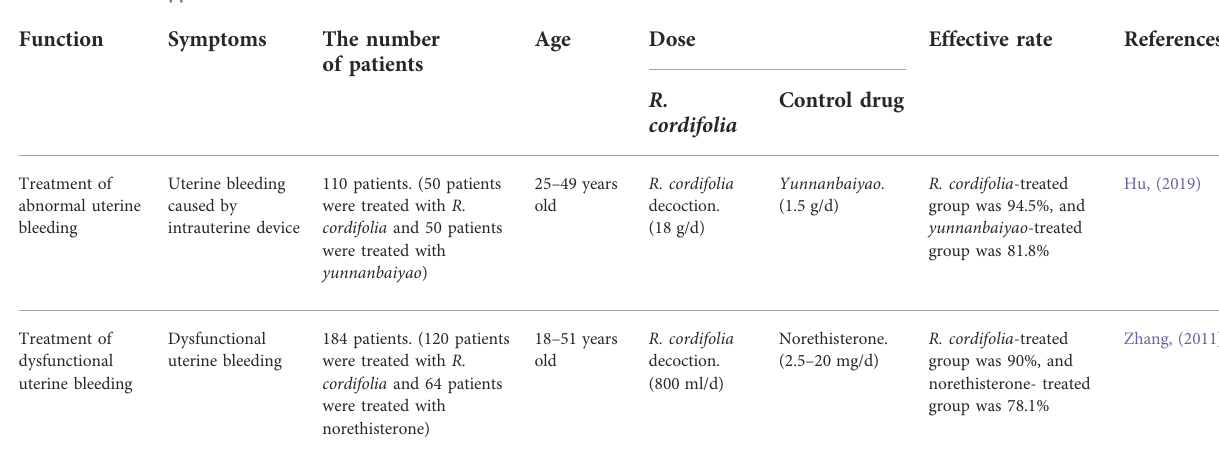
TABLE 4 Clinical application of R. cordifolia